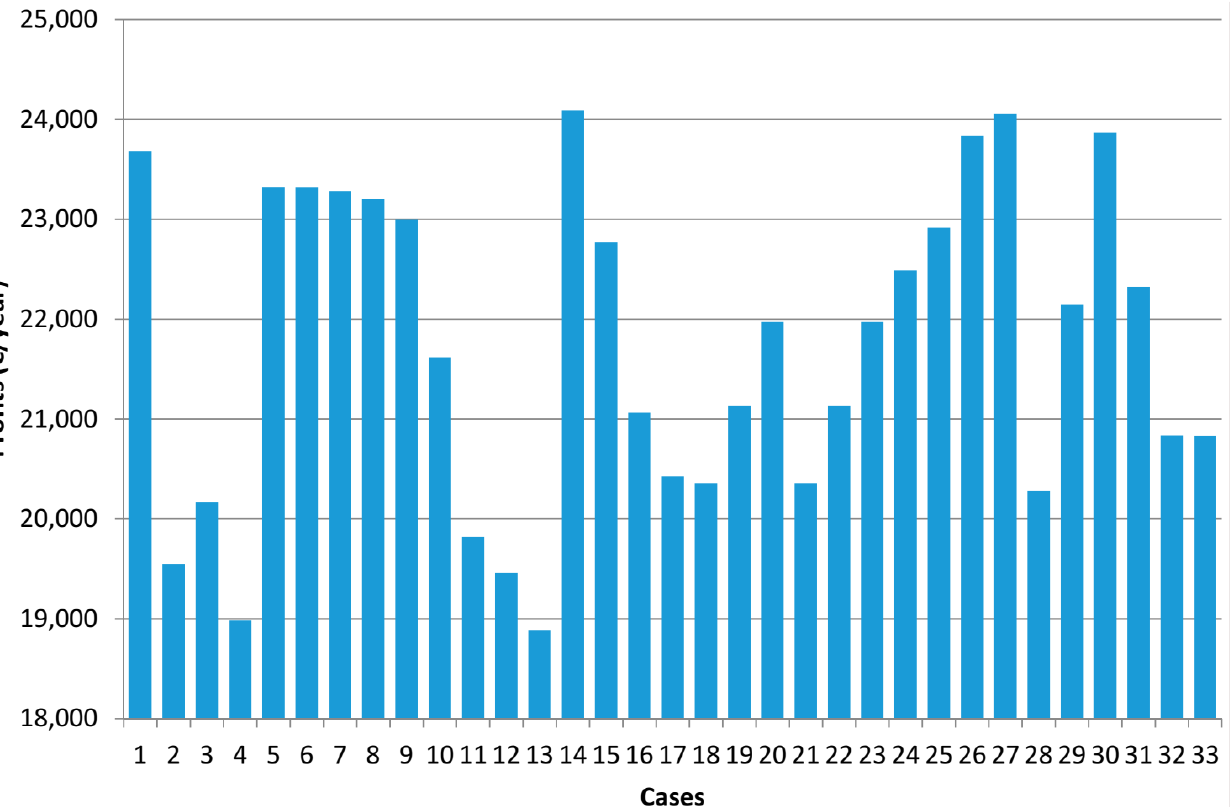
Figure 1. Annual revenue for each case based on the current